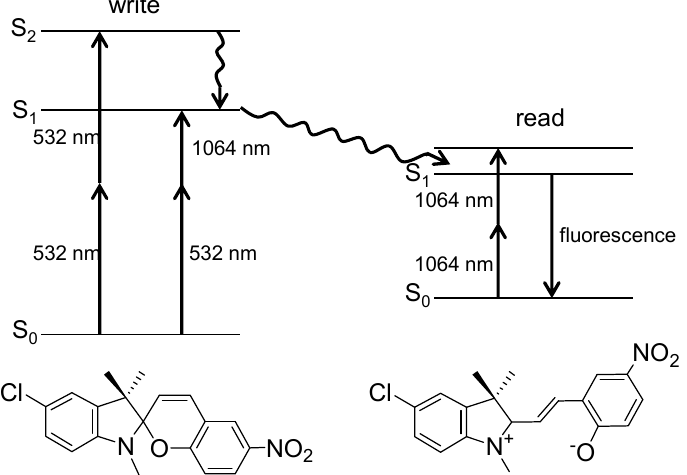
Figure 2. Energy level diagram of two-photon writing and reading